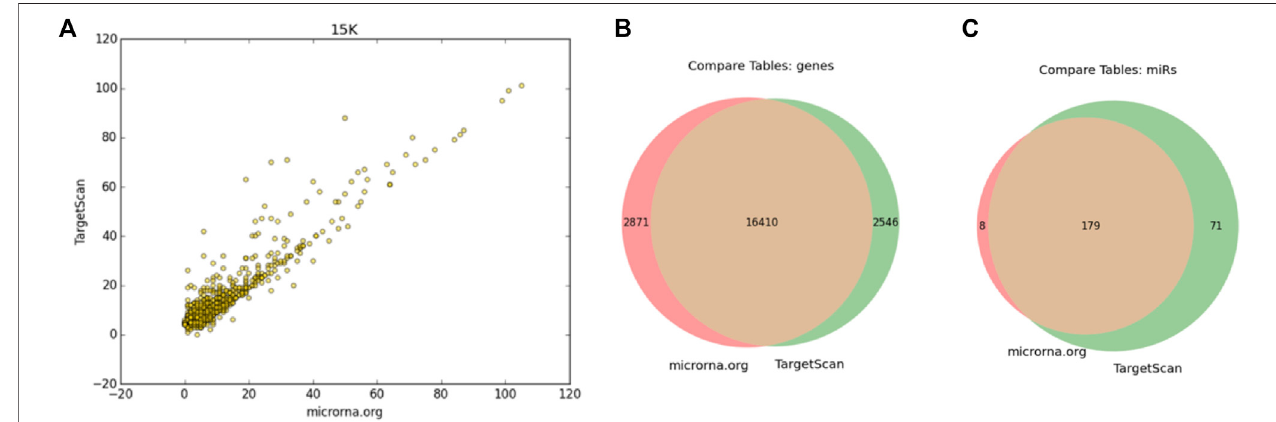
FIGURE 2 | Comparing COMICS results by applying MBS-miRNA interaction table from TargetScan and microRNA.org (A) Correlation plot following 15 k iterations with r (cid:1) 0.93. The interaction table from microRNA.org includes 1,097,065 pairs that covers 19,281 genes and 249 miRNAs, and TargetScan includes 1,183,166 pairs, 19,327 genes and 1741 miRNAs. Venn diagrams of the mRNAs (B) and miRNAs (C)